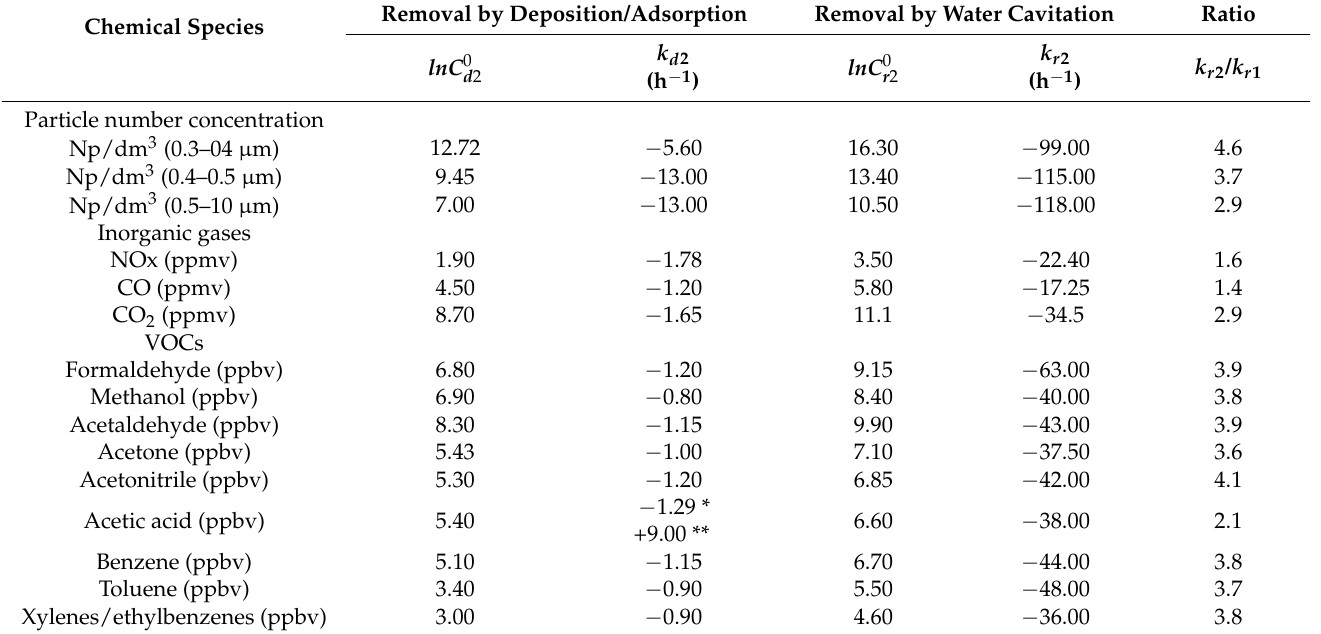
Table 3. Values of the intercepts and slopes of the t 0 regression lines obtained for various pollutants in the pulsed experiment, in Figure 5, performed with diesel exhaust emission using the GIOEL air cleaner at the maximum flow rate of air. The meaning of the subscripts d and r are the same as in Table 2. The last column shows the ratio between the values of the slopes reported in this Table and those reported in Table 2. As in Table 2, the values of lnC 0 and lnC 0 were calculated at the value of r 1 d 1 t = 0 in the graphs of Figure 5, indicated also in the text as t INIT . * Value of the slope of acetic acid measured in the first mixing phase ** values of the slope in the following mixing